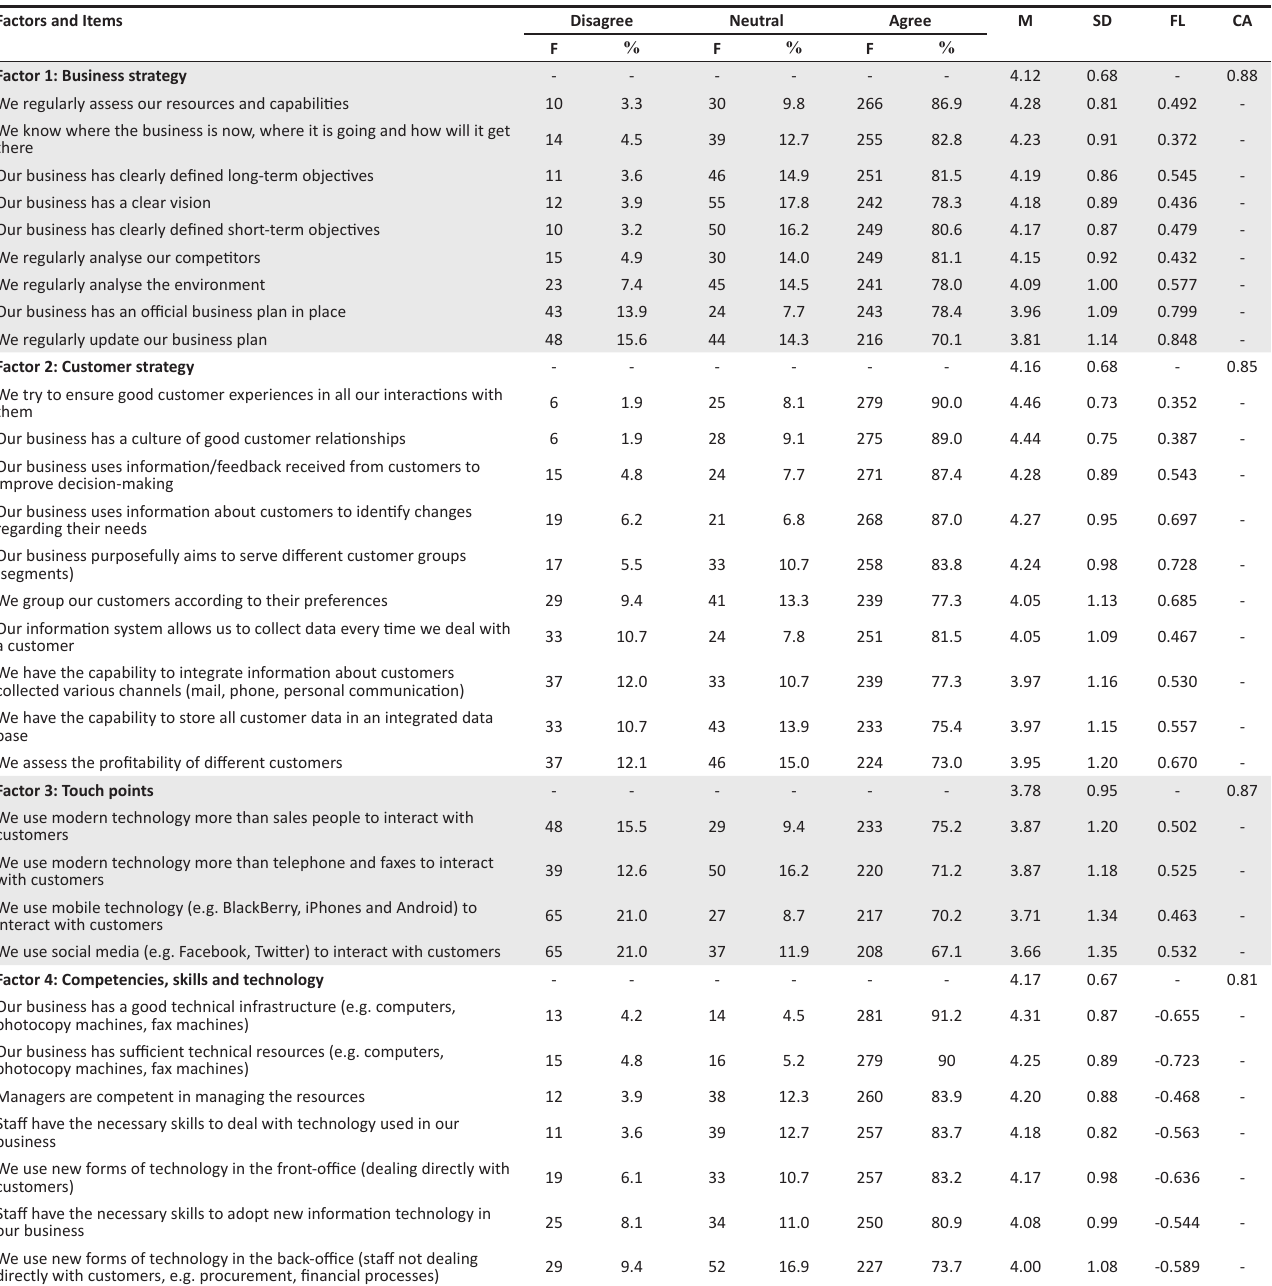
TABLE 1: Descriptive statistics and results of factor analysis. Factors and Items Factor 1: Business